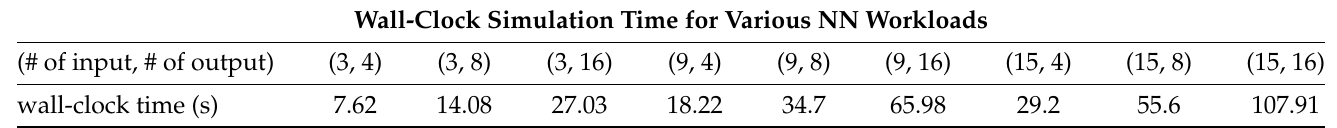
Table 3. Wall-Clock Simulation Time for Execution of various NN workloads. Wall-Clock Simulation Time for Various NN